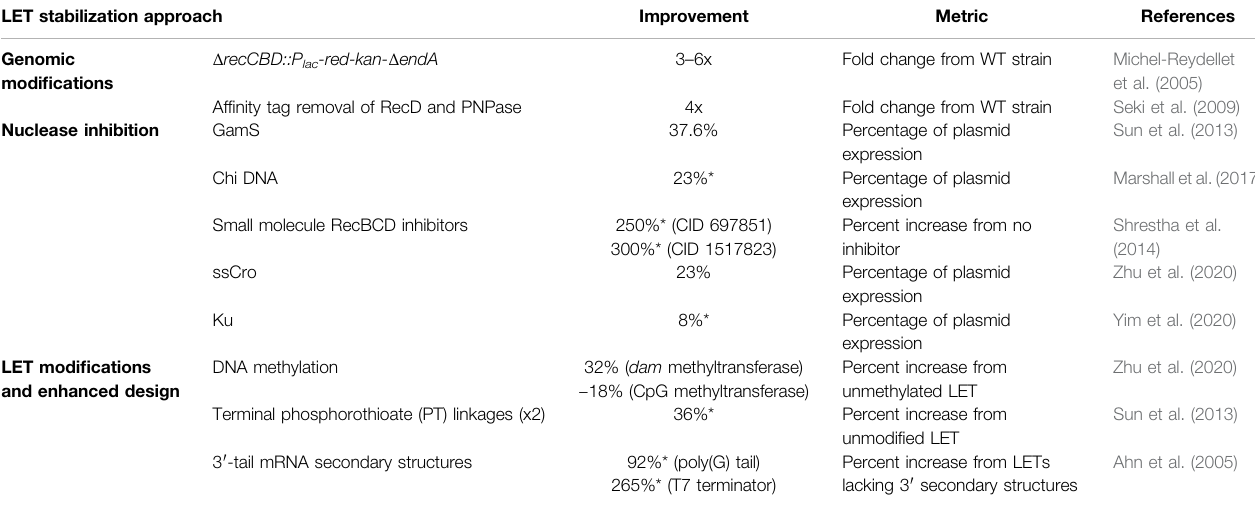
TABLE 1 | Effectiveness of different nuclease inhibition strategies quanti fi ed by their ability to improve LET-based expression in E. coli CFEs. Values with an asterisk were inferred from fi gures in the corresponding